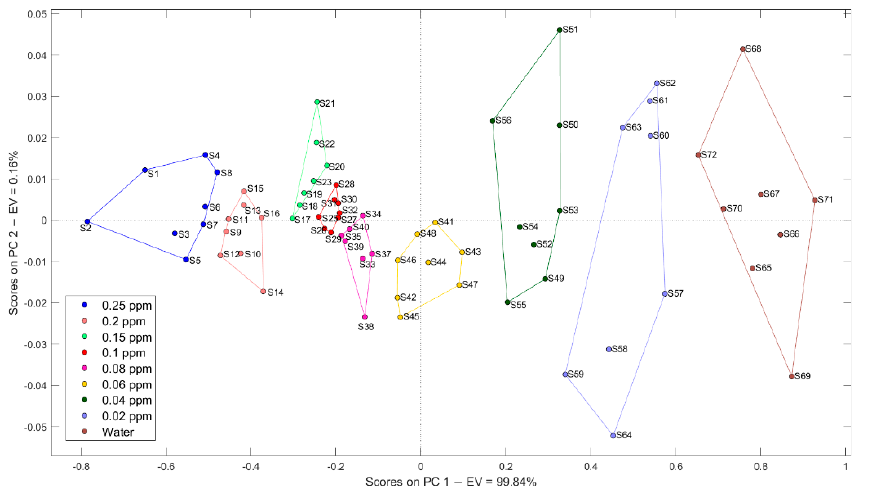
Figure 14. PCA plot using the carbon electrode (C110) to discriminate Numetrin pesticide concentrations in a distilled water solution.